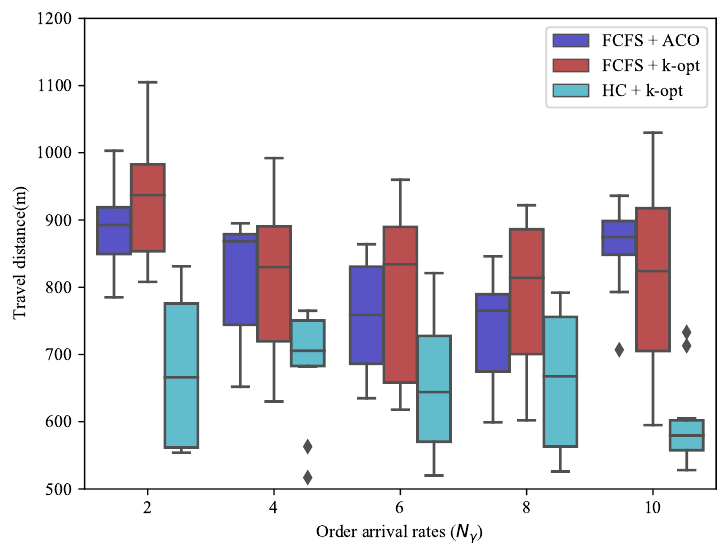
Figure 7. Comparison box plot of UAV travel distance by algorithm for order arrival rate. the rhombuses mean